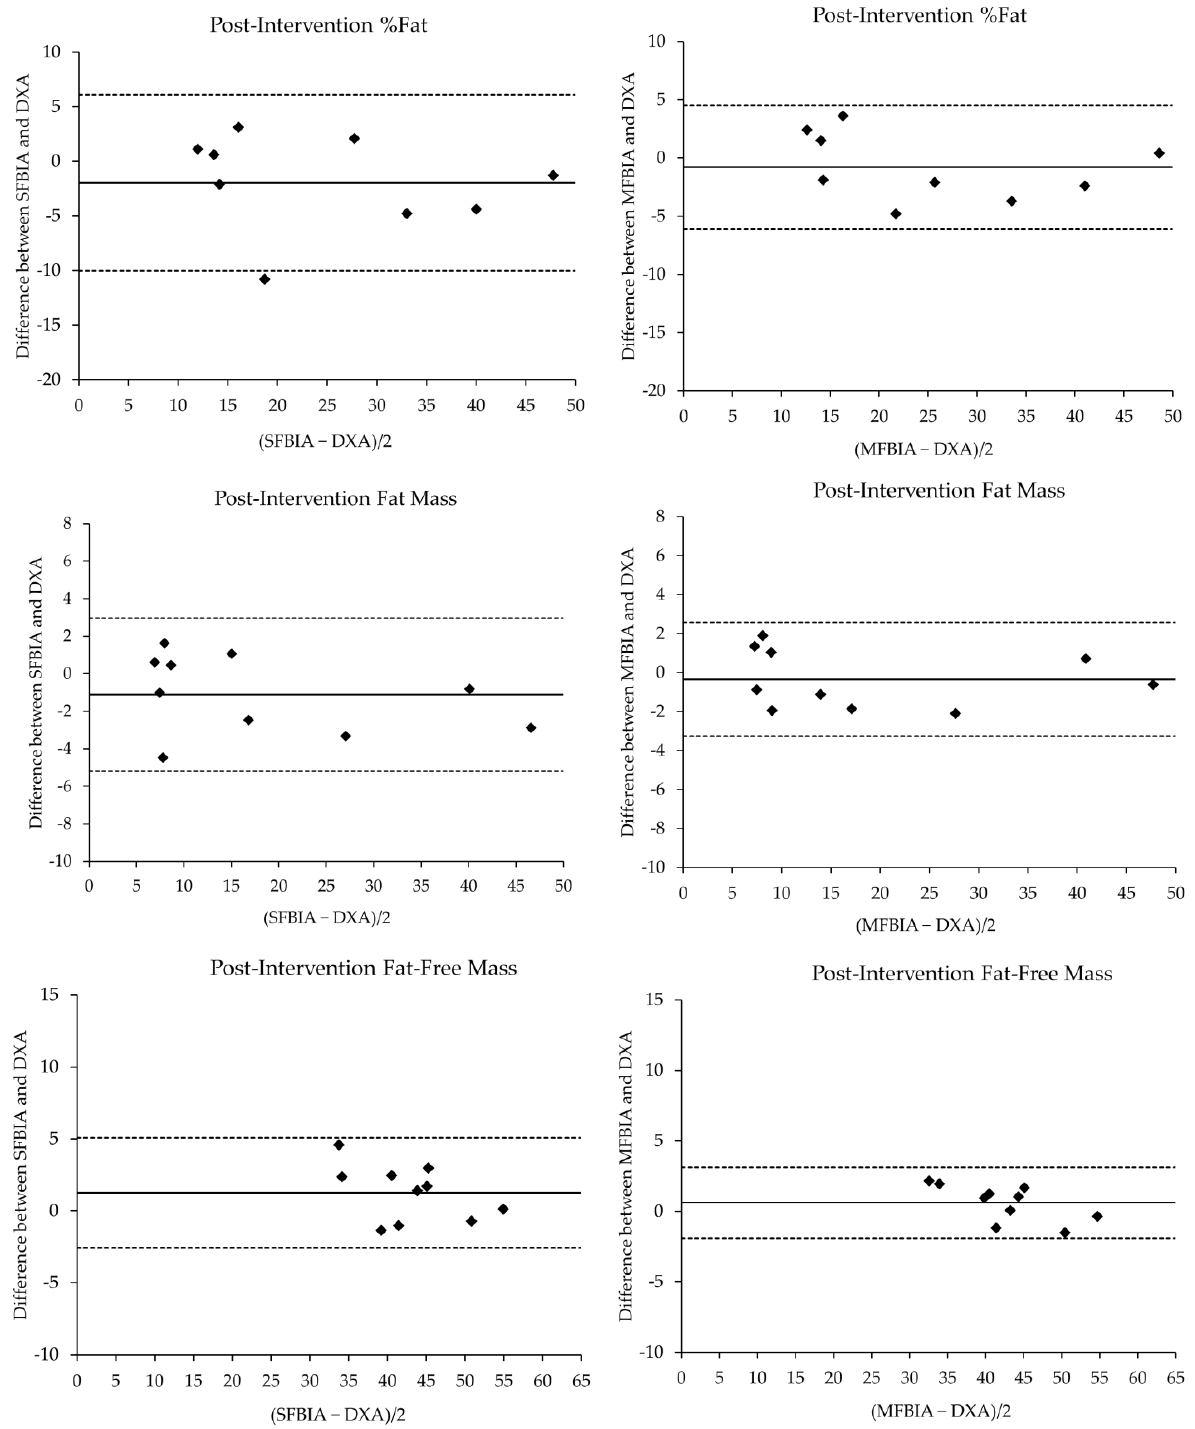
Figure 2. Bland-Altman plots comparing the post-intervention body composition metrics from single- and multiple-frequency bioelectrical impedance scales and dual energy X-ray absorptiometry. The solid lines represent the mean bias, whereas the outside dashed lines represent the 95% limits of agreement. The black circles represent each participants’ assessment values plotted between absolute difference between methods and mean difference. Fat mass and fat free mass are expressed in kg. %Fat = percent body fat, DXA = dual energy X-ray absorptiometry, MFBIA = multiple-frequency bioelectrical impedance analysis, SFBIA = single-frequency bioelectrical impedance